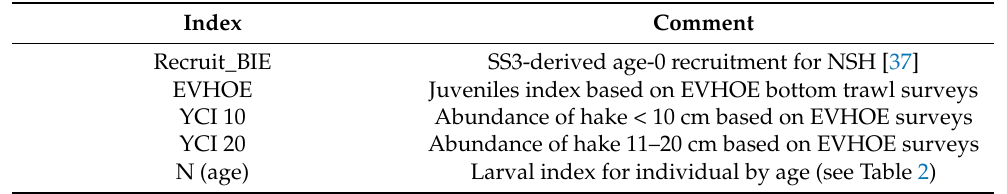
Table 3. Year–class index used for the analysis.